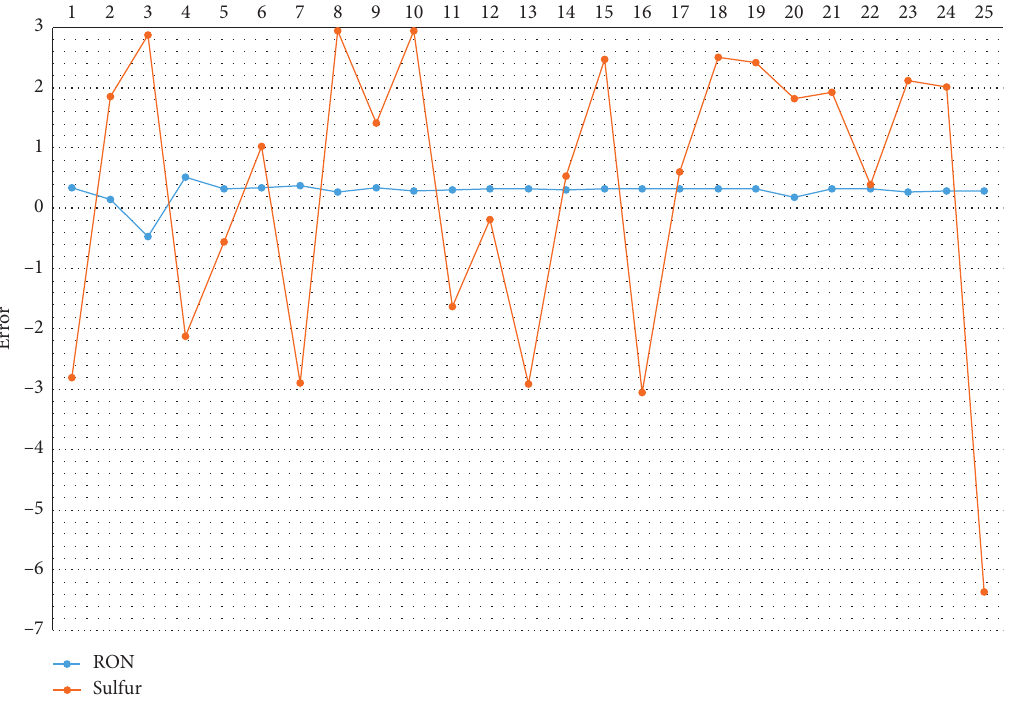
Figure 8: Error between the predicted value and the true value.